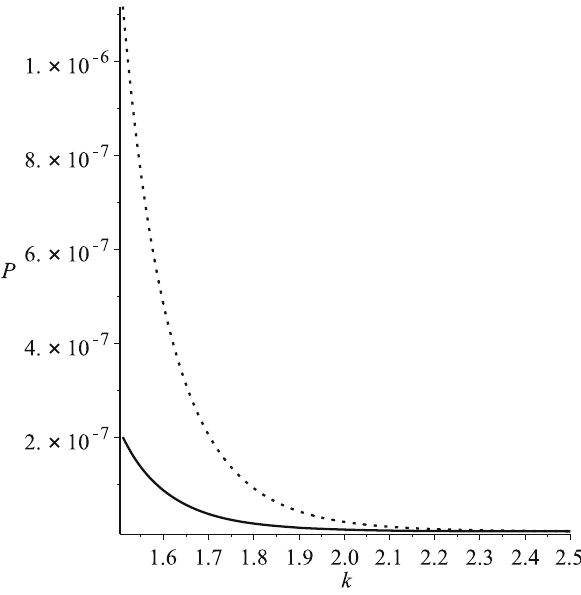
Fig. 3 P asafunctionof k for p / p (cid:8) = 0 . 01solidlineand p / p (cid:8) = 0 . 03 the point line. Angle β − ϕ = 0